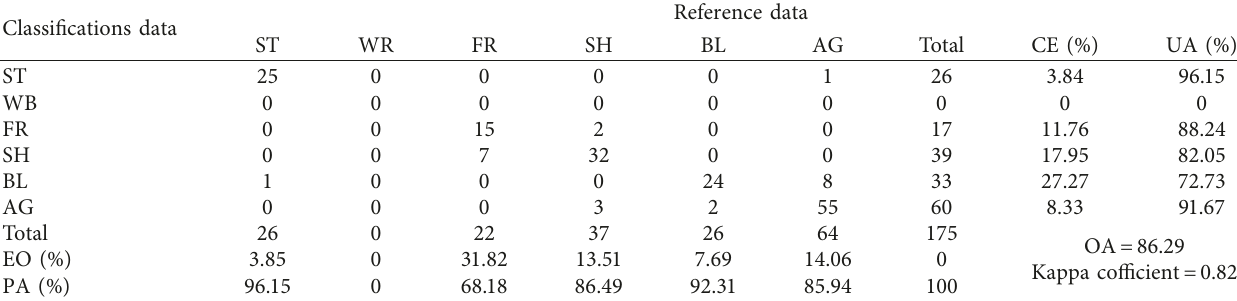
Table 3: Confusion matrix accuracy for the classification of 2000.